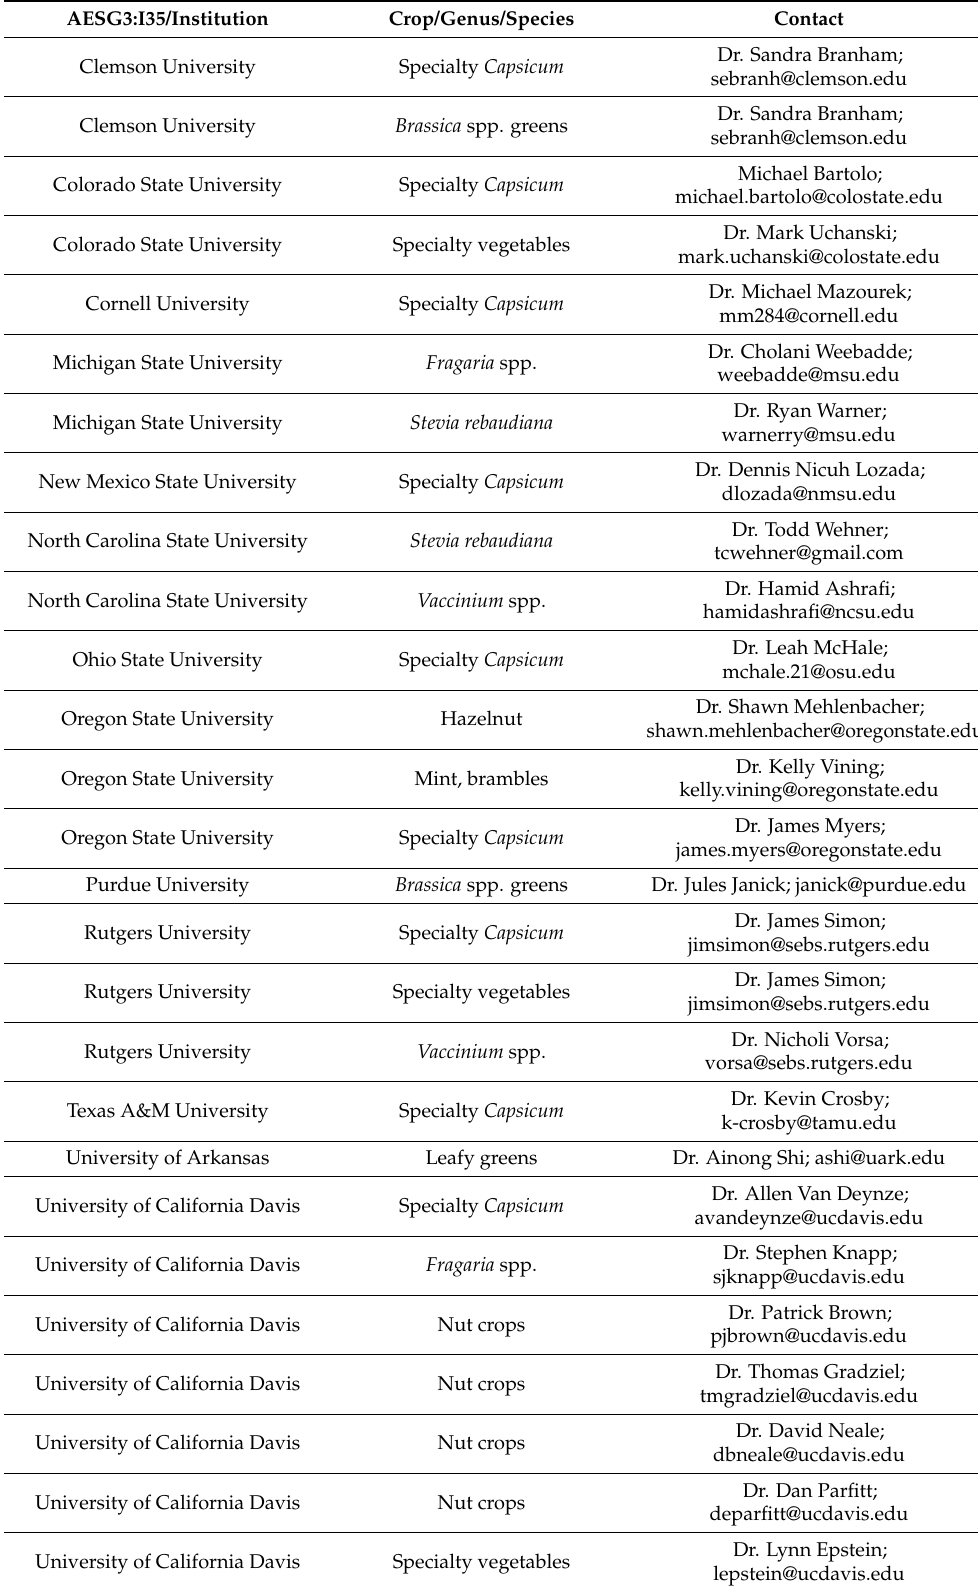
Table 2. A partial list of public breeding programs focusing on specialty crops within the U.S. land grant university system with contact